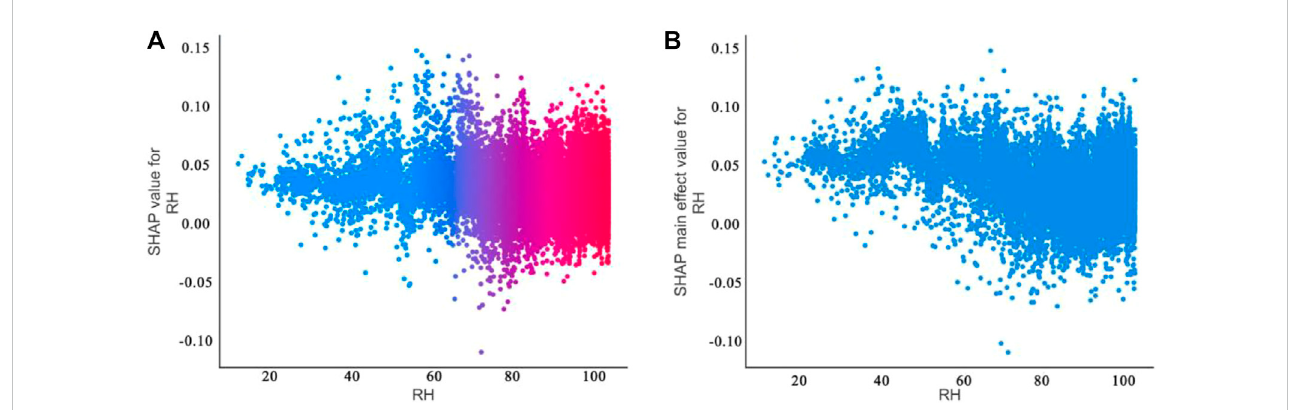
FIGURE 7 Characteristic-dependentplotsofrelativehumidity(%): (A) featuredependencygraphthatrepresentsthecomprehensiveinteractionofalltheremaining input features on the RH (%) ; (B) feature dependency graphs that eliminate interactions.